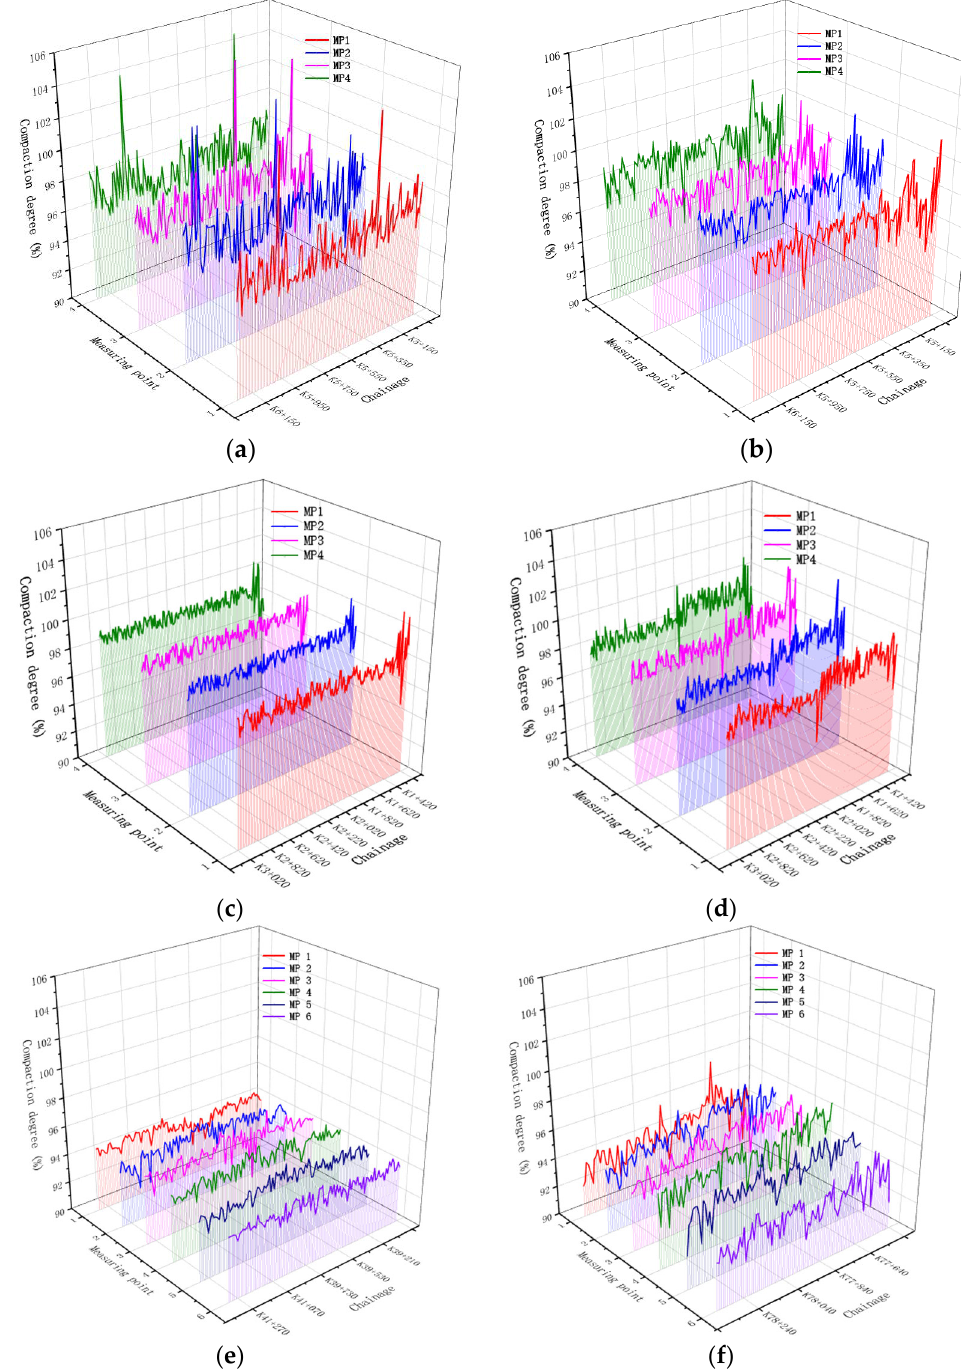
Figure 6. Compaction degree of the test road: ( a ) test section A; ( b ) test section B; ( c ) test section C;